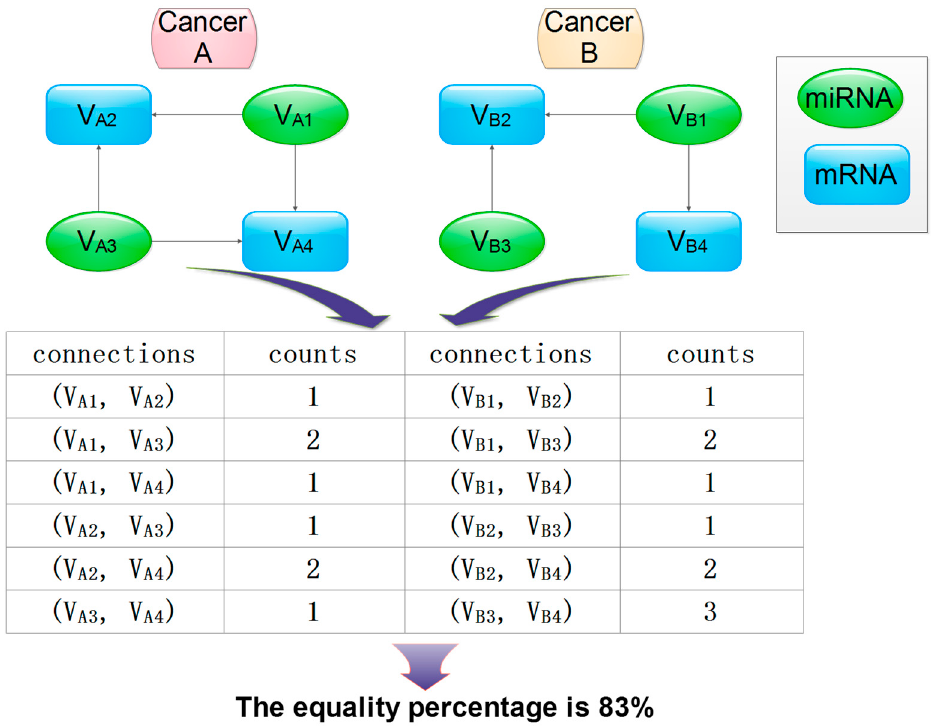
Figure 3. A schematic representation of the graph comparison algorithm to detect correlated clusters or local similarities in two graphs. The count was calculated as the number of connections between two nodes.